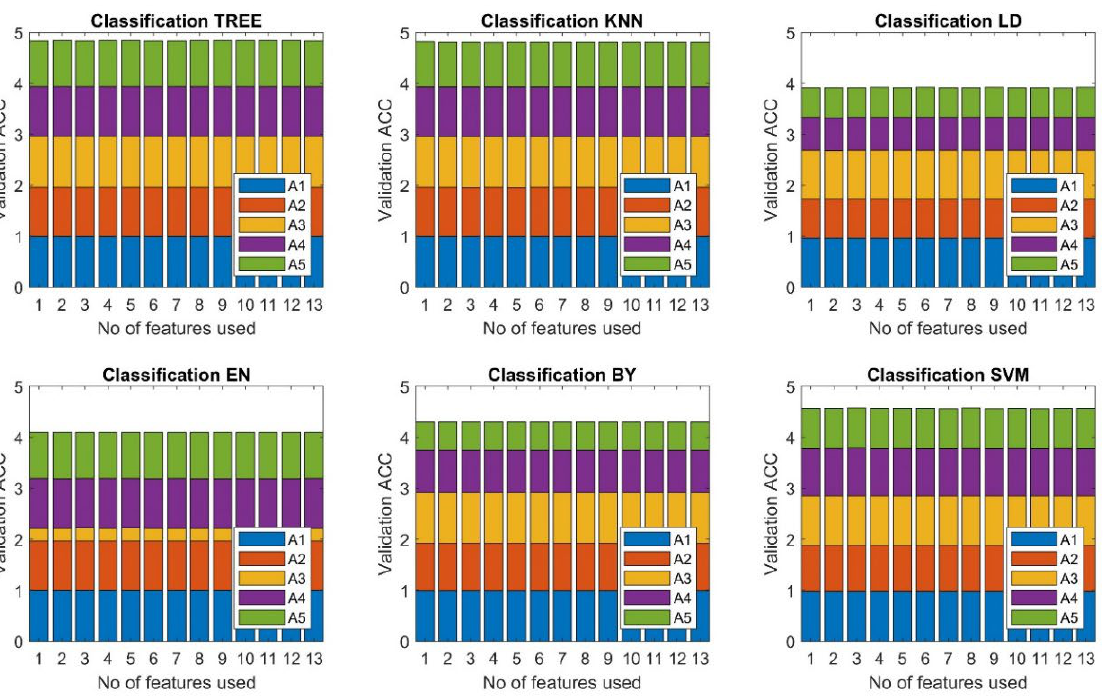
Figure 11. Stacked bar plot depicting validation accuracy values gathered for particular antenna types and algorithms when using various No of features according to MRMR method.